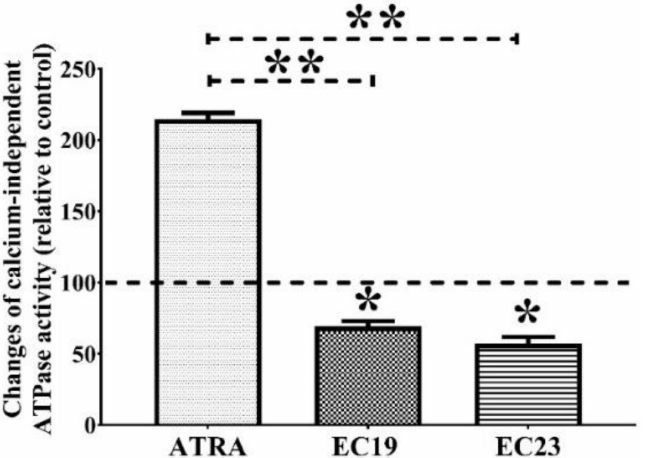
Figure 2. The total activity of calcium-independent ATPases after the exposure of Caco-2 cells to retinoids. Caco-2 cells were treated with the IC 50 concentration of the indicated retinoids for 24 h and the enzymatic activity was measured colorimetrically. The ATPase activity observed in 0.1% DMSO control was normalized to 100% (the dotted line represents the control). The activity in presence of EC-synthetic retinoids was then detected and compared to the control and ATRA. Shown is the mean change in ATP-degrading activity ± SEM of three independent experiments ( n = 3). * p < 0.05 (compared to the control) and ** p < 0.01 (compared to ATRA) indicated statistically significant difference. 2.5. EC19 and EC23 Induce DNA Fragmentation and Genotoxicity in Caco-2